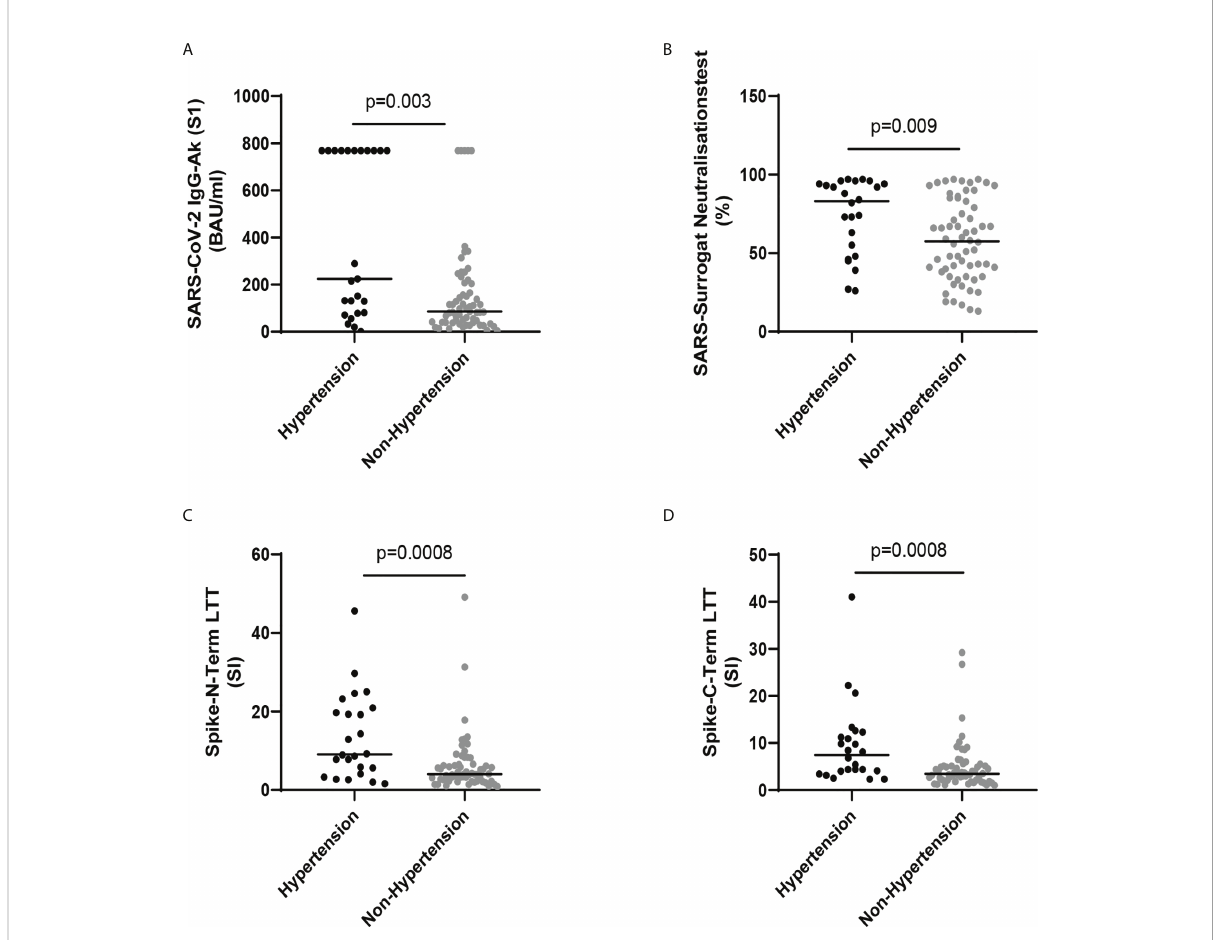
FIGURE 1 (A) SARS-CoV-2 IgG-Ab (S1) (BAU/ml) in SARS-CoV-2 infected health care workers (HCWs) with and without hypertension. (B) SARS surrogate neutralization test (%) in SARS-CoV-2 infected HCWs with and without hypertension. (C) Spike-N-Term LTT (SI) in SARS-CoV-2 infected HCWs with and without hypertension. (D) Spike-C-Term LTT (SI) in SARS-CoV-2 infected HCWs with and without hypertension. Lines show median. Comparison was made by Mann-Whitney U